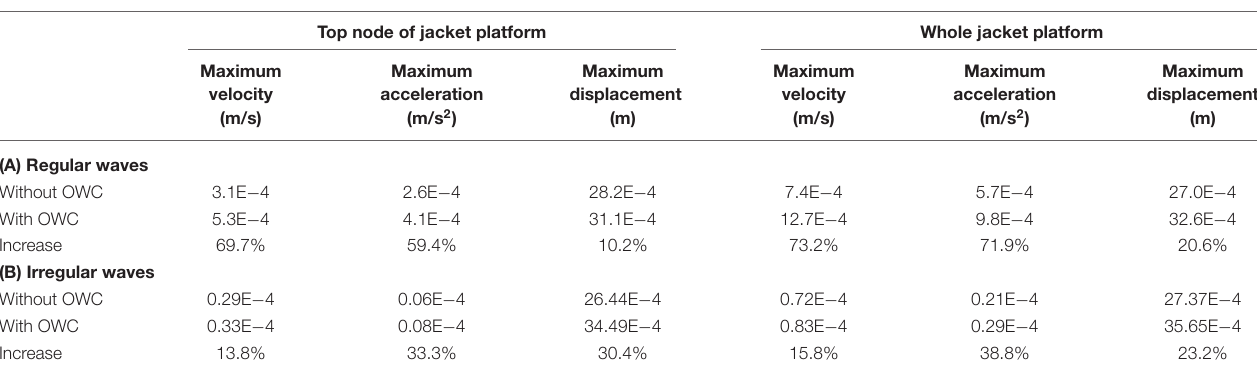
TABLE 4 | Statistics of dynamic responses under working condition. Top node of jacket platform Whole jacket